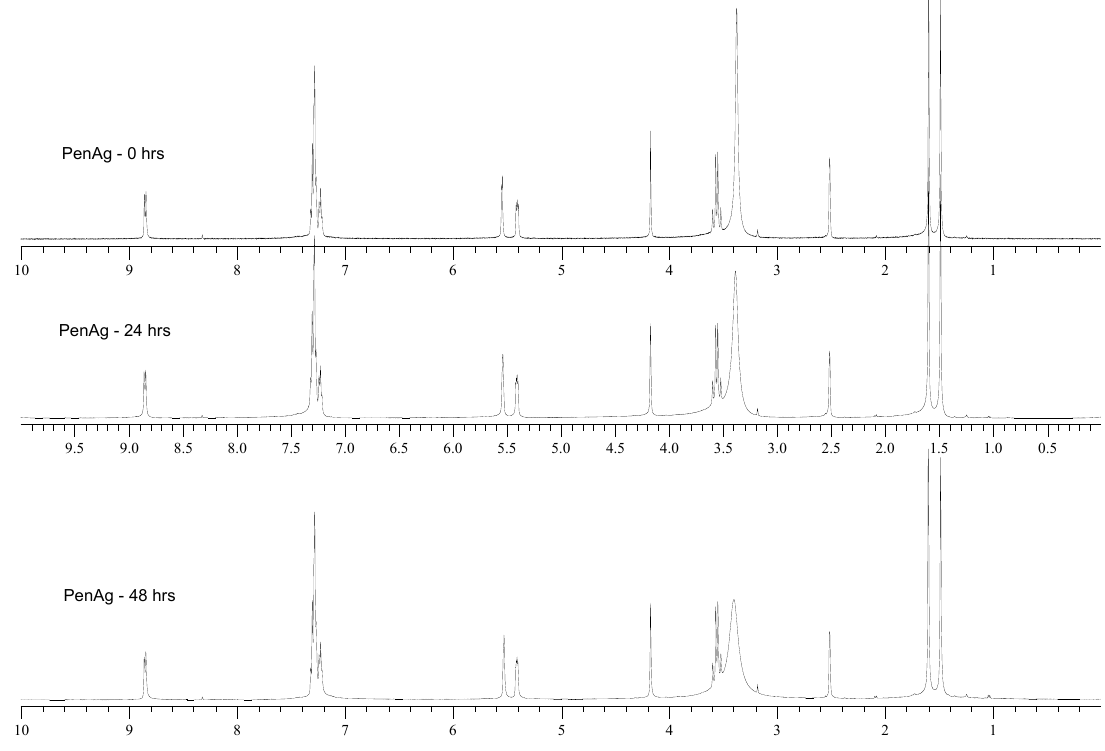
Figure 2. 1 H-NMR spectrum in DMSO- d 6 of PenAg and the corresponding ones after 0, 24 and 48 h.